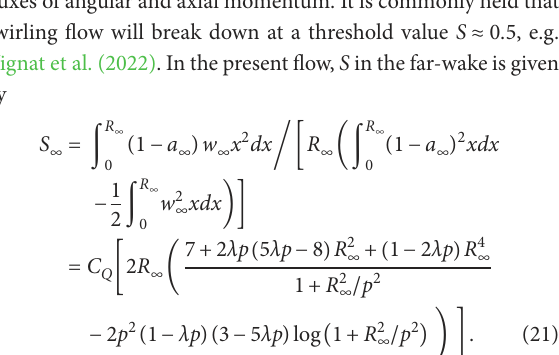
FIGURE 2 Iteration of the power coefficient ( □ ) and λ p (×) for λ =